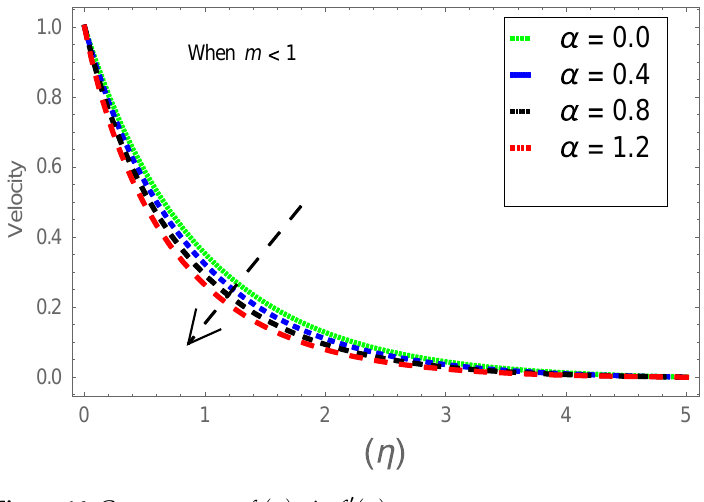
Figure 16. Consequence of ( α ) via f (cid:48) ( η ) .